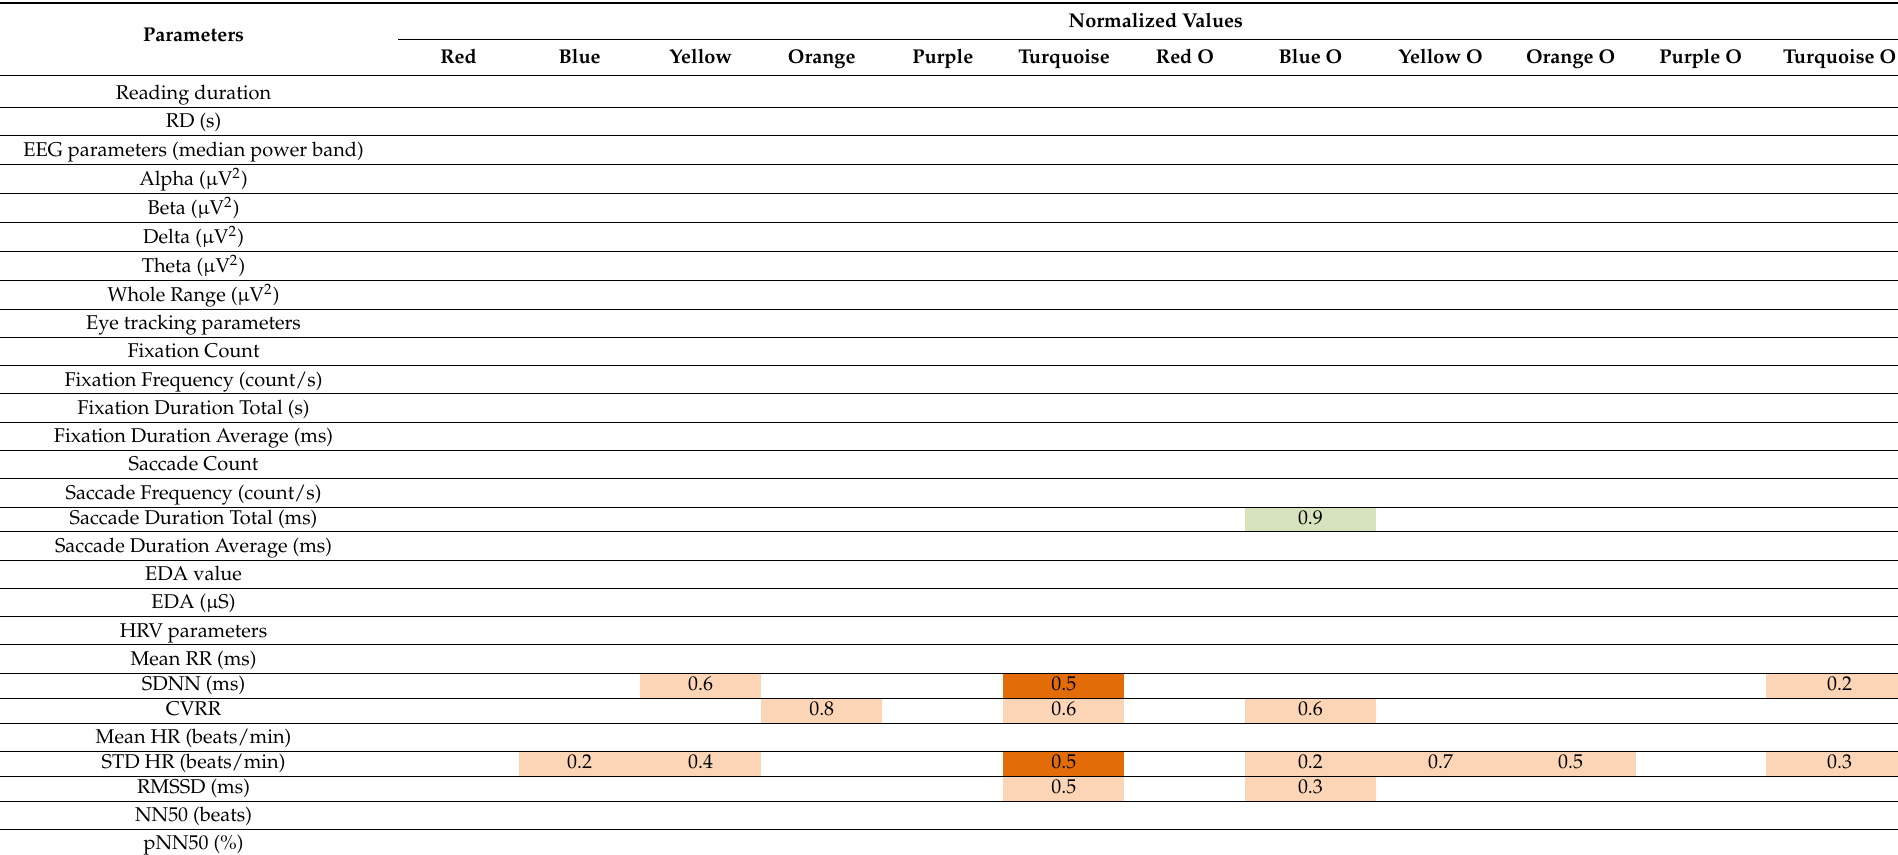
Table 3. Differences between second and third graders on reading duration, EEG, eye tracking, EDA and HRV parameters (normalized on white color), ( p < 0.05 is marked with pale orange color, and p < 0.01 is marked with dark orange color). The values in the table represent Cohen’s D effect